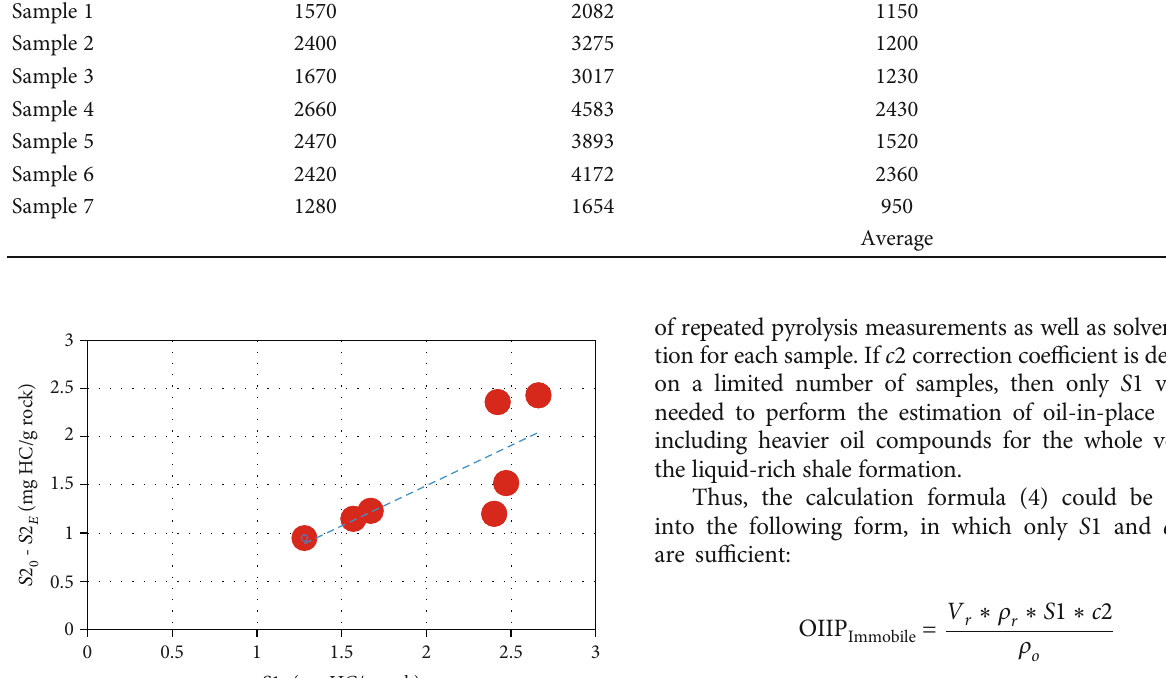
— a value of Rock Eval S 1 parameter obtained in a 0